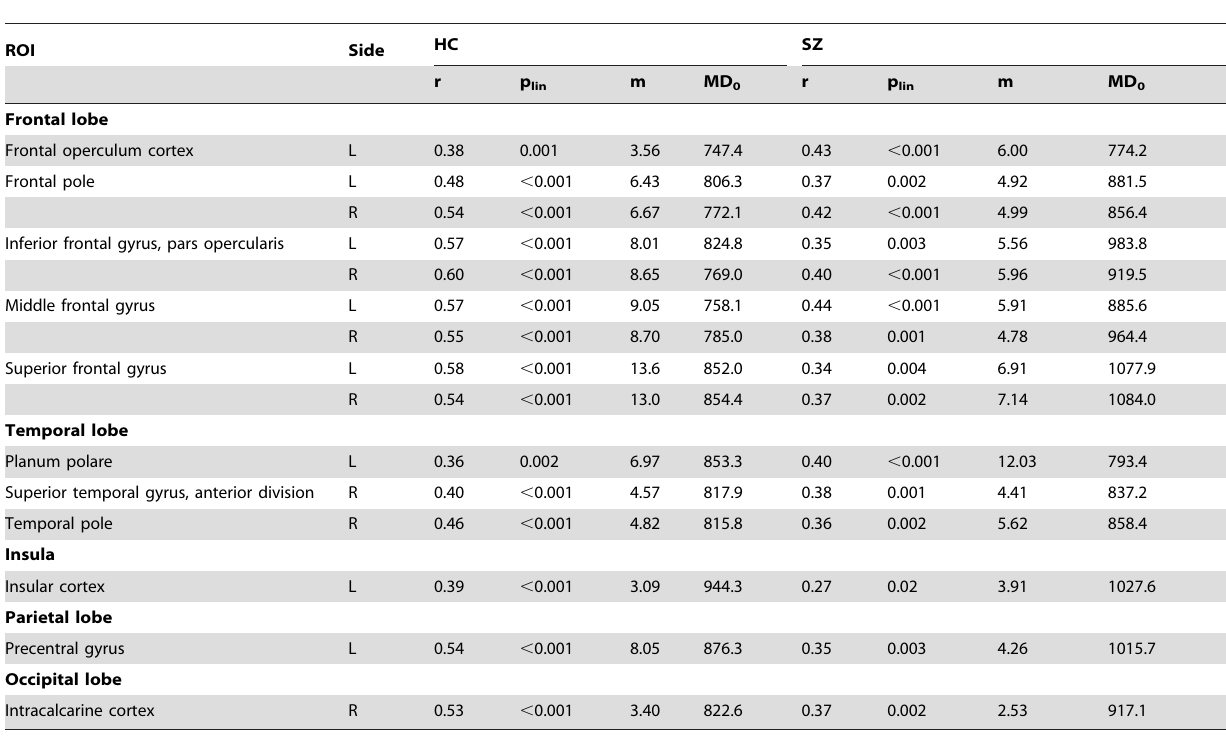
Table 4. Relationships between mean diffusivity and age in SZ and HC subjects.